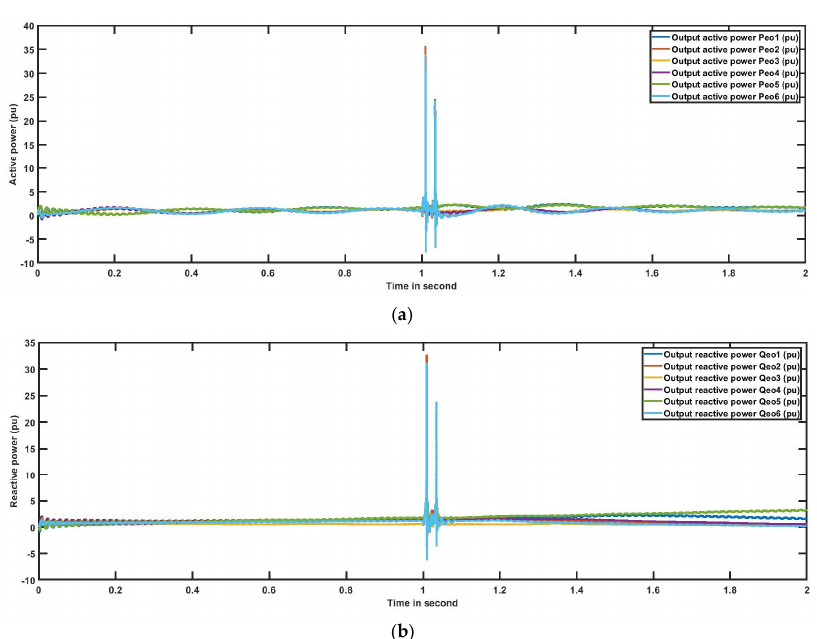
Figure 17. Inter-area voltage for 3LG temporary fault at location B.